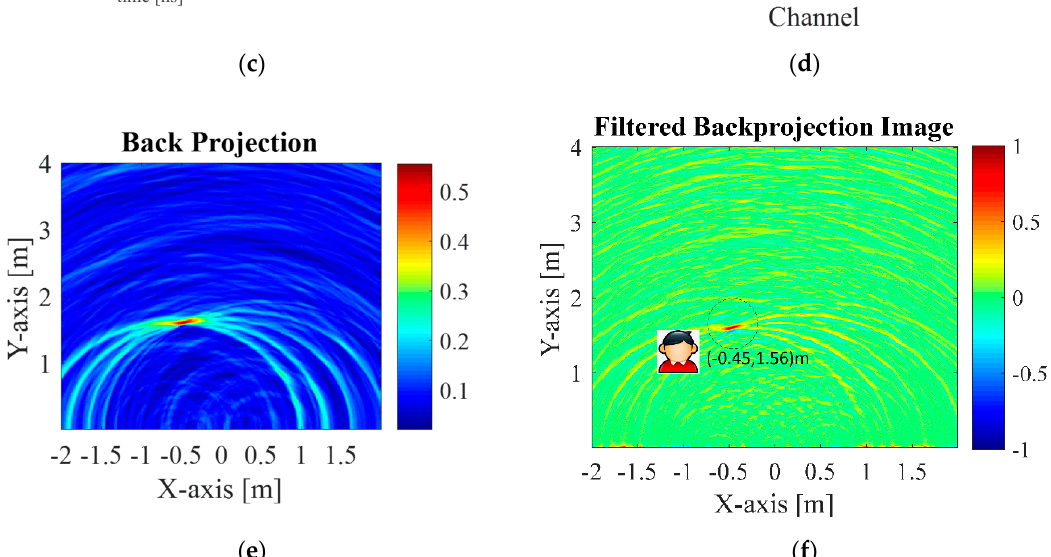
Figure 9. Through-the-wall detection of one human subject at ( − 0.5 m, 1.5 m) and a mannequin at (0, 1 m): ( a ) the experimental scene with real human and mannequin; ( b ) raw data of each channel; ( c ) statistical variance analysis of each channel, ( d ) statistical variance analysis of each channel on 2D display, ( e ) radar imaging by back projection, ( f ) refined radar imaging using Sinc-filtered back projection.